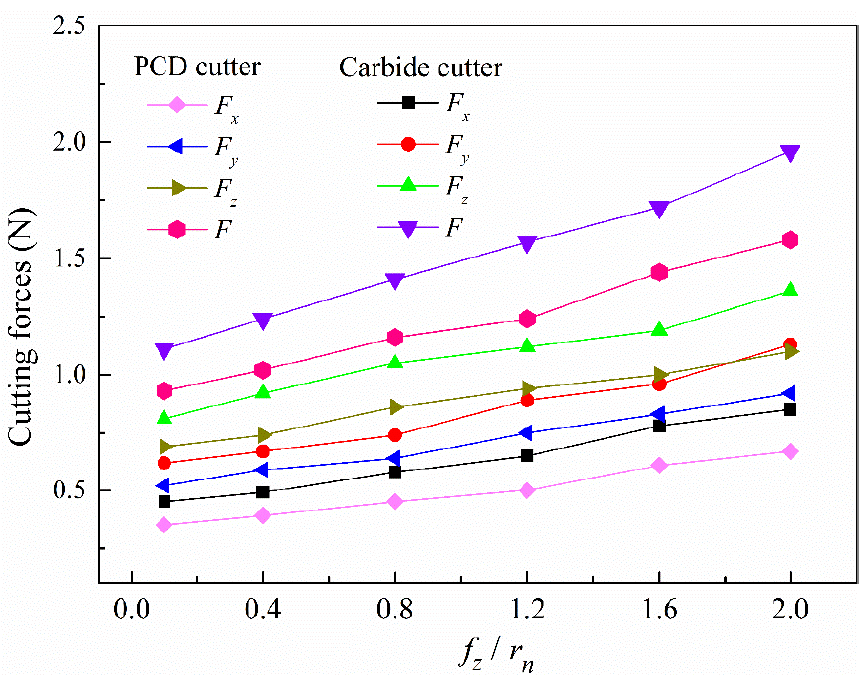
Figure 7. Variations of cutting forces with f z / r n .